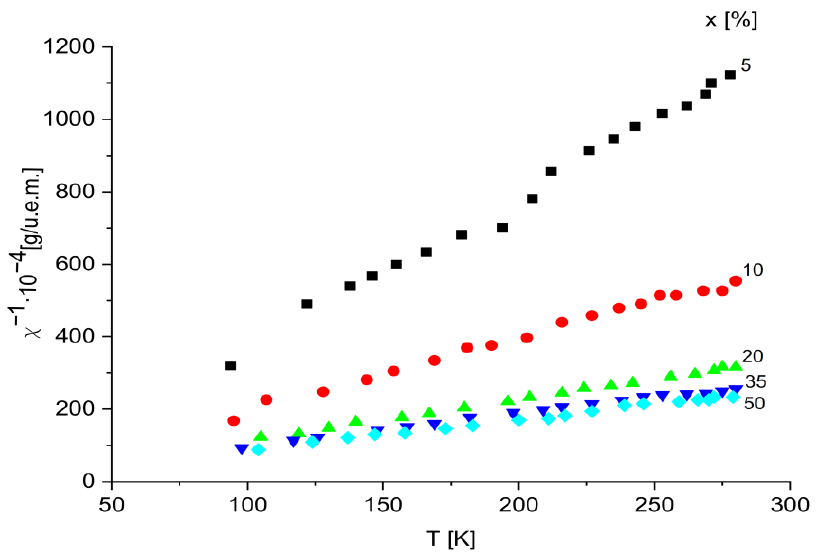
Figure 4. Relation between temperature and the reciprocal magnetic susceptibility for x(Fe 2 O 3 · V 2 O 5 ) · (100 − x)[P 2 O 5 · CaO] glasses with 0 < x < 50 mol